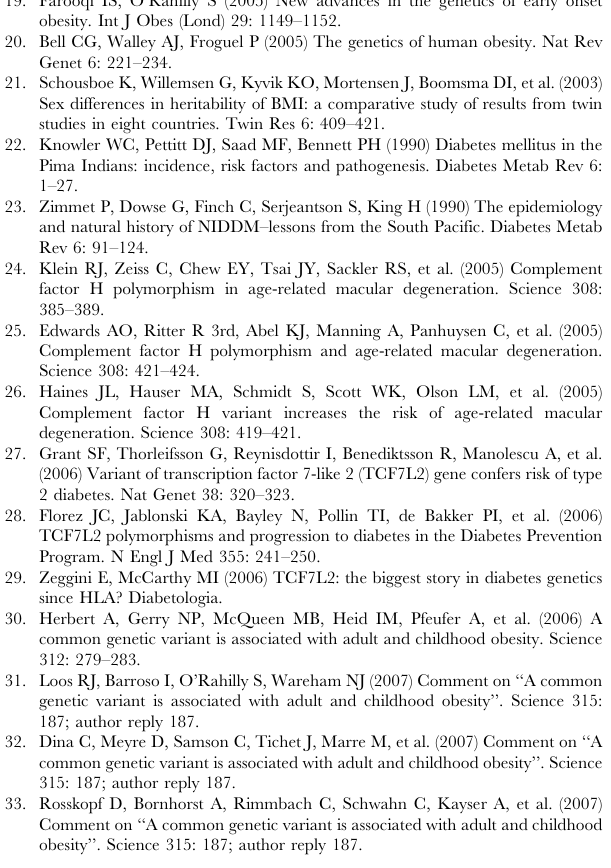
Figure S1 FTO region of LD in cohorts in the study